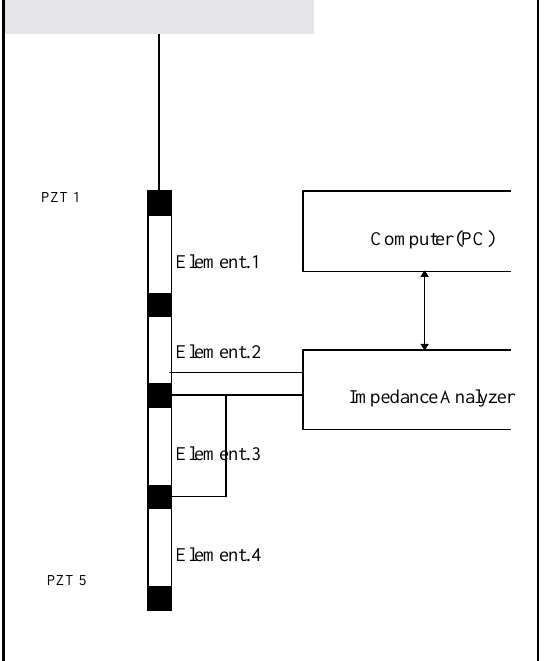
Fig. 1. Experimental setup of the aluminum